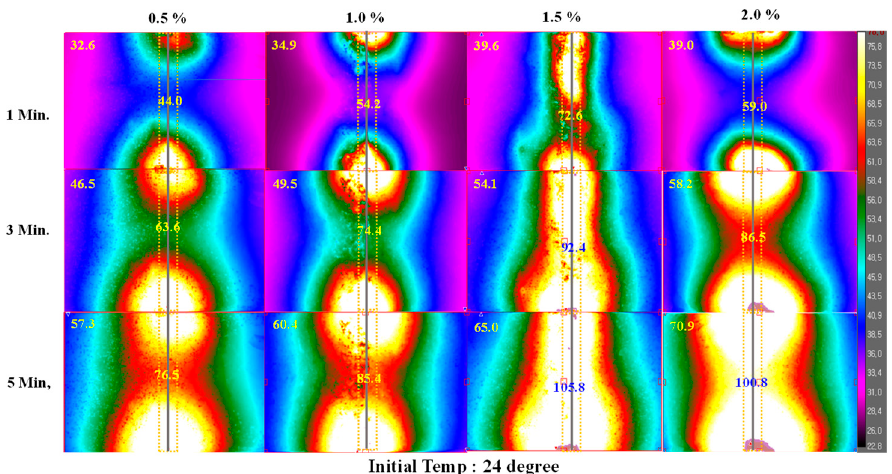
Figure 6. Heat/Temperature distribution patterns of another prism set. The numbers represent average temperatures of the prism surface ( top left corner of each image) and the minimum volume surface ( middle ). The dotted vertical rectangle and the solid line in each temperature distribution represent the surface area of the minimum volume and the bisect line of the rectangle, respectively.